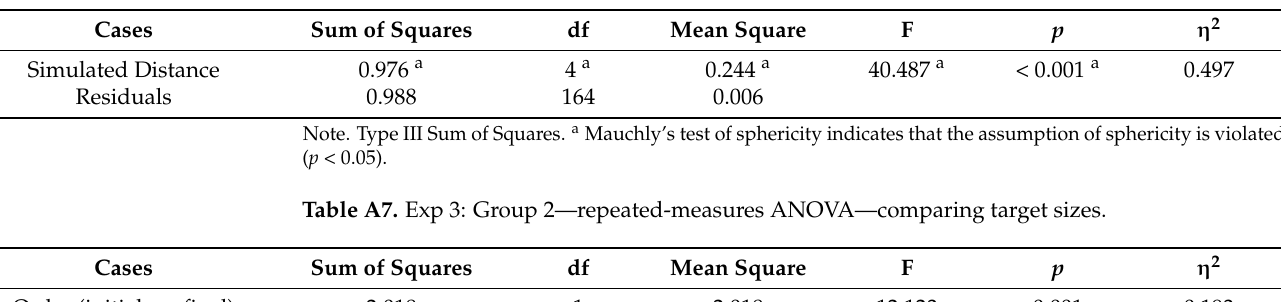
Table A6. Exp 3: Group 1—repeated-measures ANOVA—comparing target sizes.